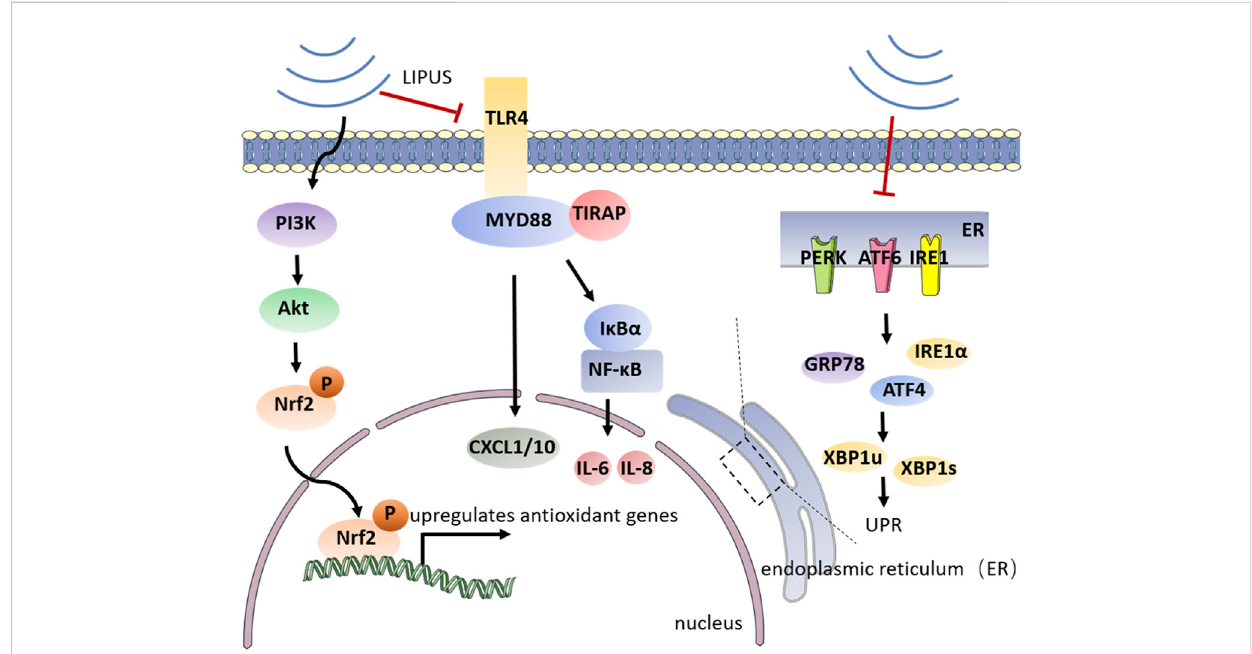
FIGURE 4 Schematic illustration of the mechanism by which LIPUS regulates periodontal in fl ammation. LIPUS can release UPR and reduce the secretion of chemokines such as IL-6, IL-8, and CXCL1/10 by inhibiting TLR4-mediated NF- κ B signaling pathway and speci fi c transmembrane signaling transducers on the endoplasmic reticulum surface. LIPUS can also activate the PIS/Atk signaling pathway to further upregulate antioxidant genes and alleviate oxidative